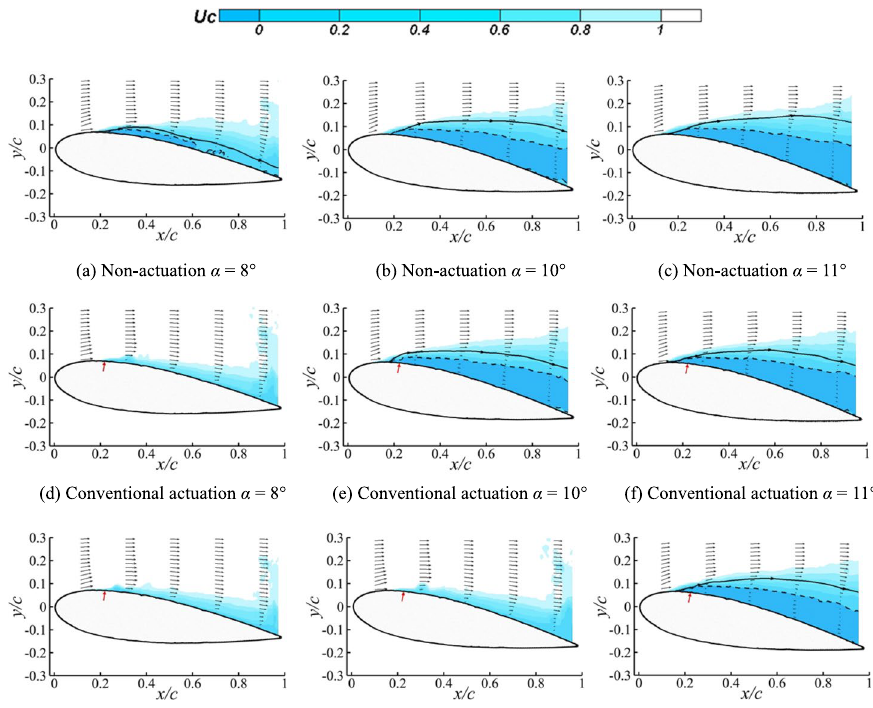
Fig. 7 2D airfoil upper surface velocity contour under different actuation states. Black arrows: velocity profiles at selected streamwise locations; solid black line: dividing streamline; dotted black line: contour lines of U c (referred to as zero‑velocity lines); the jet orifice position is indicated by a red